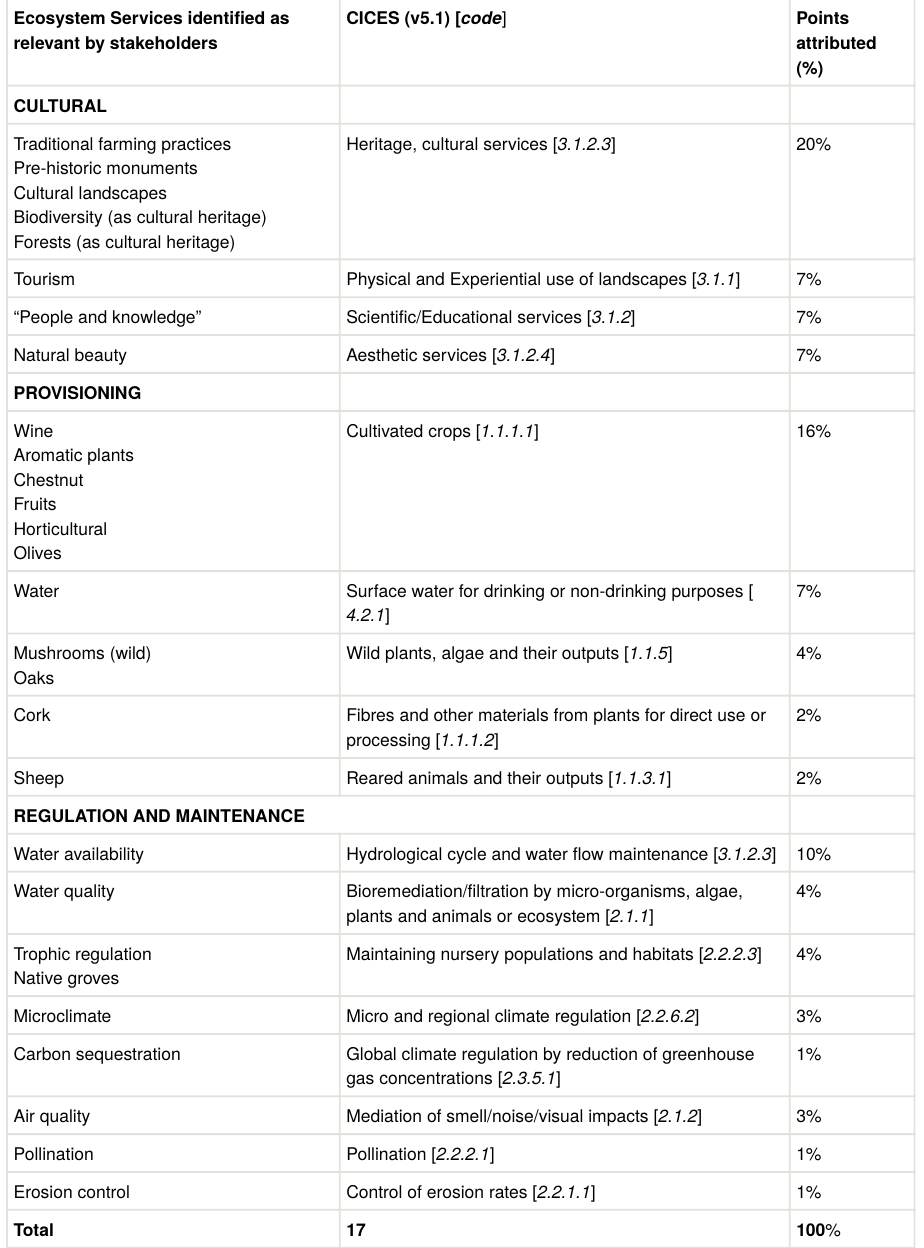
Table 3. Ecosystem Services identi fi ed as relevant by stakeholders, correspondence with CICES classi fi cation and prioritisation of ES by stakeholders through the Ecosystem Services identi fi ed as relevant by stakeholders